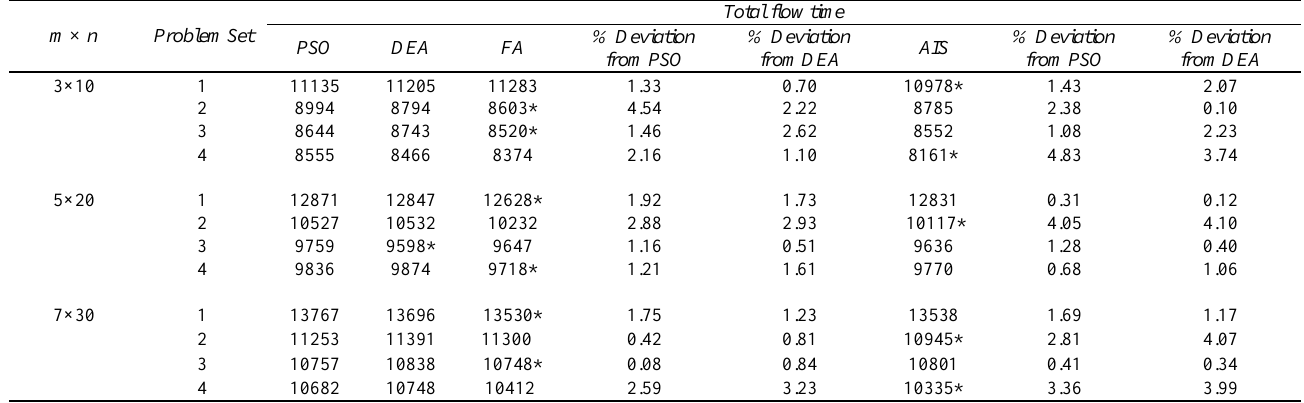
Table 9 – Comparison between FA, AIS, DEA and PSO for equal size sublots (total flow time)